Question: Give a one-sentence summary of this figure.
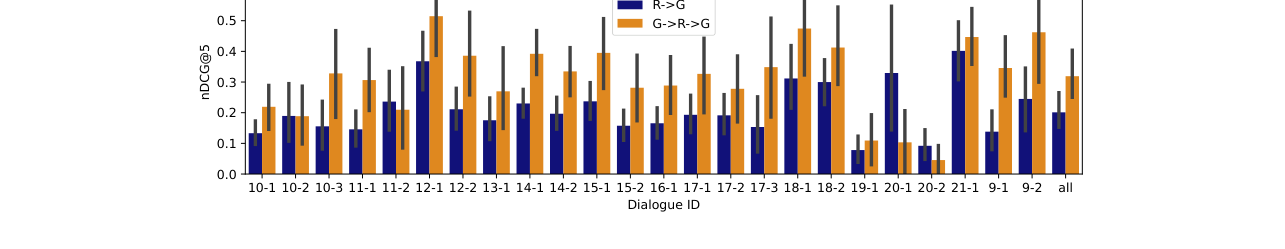
Answer: nDCG@5 aggregated for each dialogue across all runs on the passage ranking task. We report the average across runs, median or better.